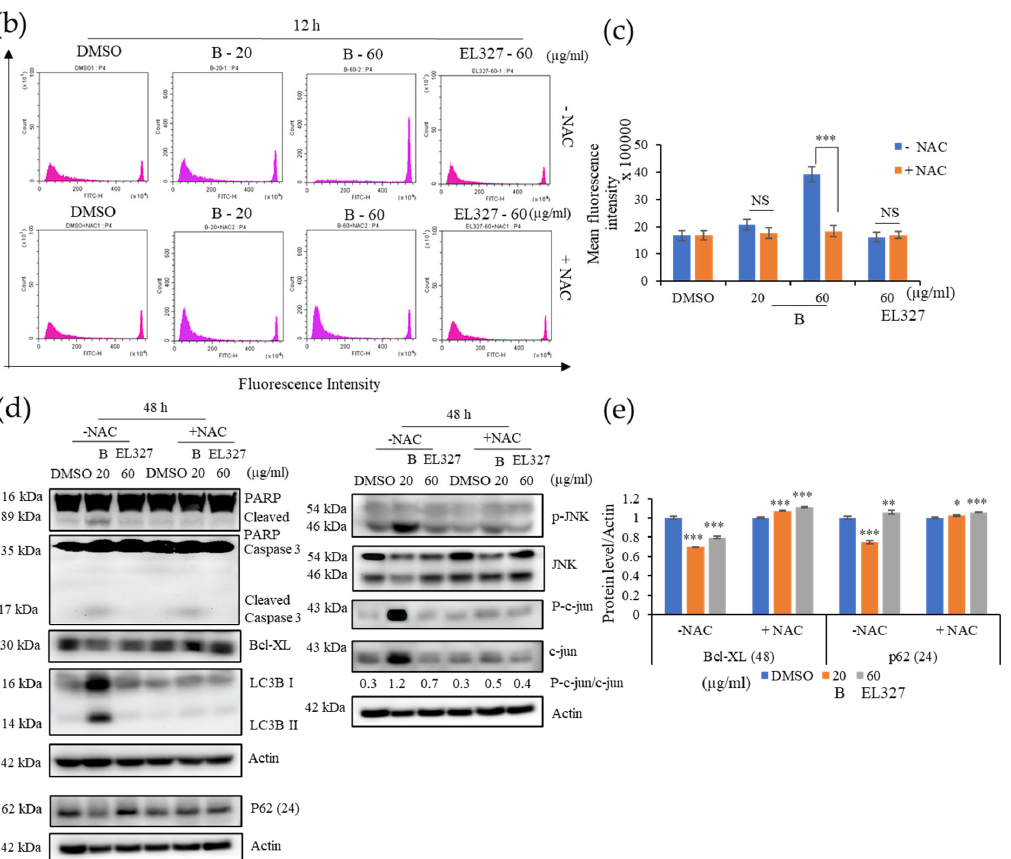
Figure 5. B induces ROS generation and activates JNK signaling in Caco2 cells. ( a ) Intracellular ROS generation was detected by fluorescence microscopy using DCFH ‐ DA (10 μ M) in Caco2 cells treated with B (20, 60 μ g/mL) or EL000327 (60 μ g/mL) for 12 h with or without the ROS inhibitor NAC (5 mM). ( b ) Flow cytometric analysis of the fluorescence intensity of Caco2 cells preincubated with DCFH ‐ DA (10 μ M) and treated with B (20, 60 μ g/mL) or EL000327 (60 μ g/mL) for 12 h with or without NAC (5 mM). ( c ) Quantification of the mean fluorescence intensity of Caco2 cells preincubated with DCFH ‐ DA (10 μ M) and treated with the indicated concentrations of B for 12 h in the presence or absence of NAC. ( d ) Western blot analysis of PARP, caspase ‐ 3, Bcl ‐ xL, p62, LC3BI/II, p ‐ JNK, JNK, p ‐ c ‐ jun, and c ‐ jun protein expression after treatment with B (20, μ g/mL) or EL000327 (60 μ g/mL) for 24 or 48 h, with or without NAC (5 mM). ( e ) Quantification of Bcl ‐ XL and p62 protein expressions in the presence or absence of NAC. Data represent the mean ± S.D. * p < 0.05, ** p < 0.01, *** p < 0.001; NS: no significant difference ( p > 0.05) compared with the NAC ‐ treated group or the DMSO ‐ treated control.